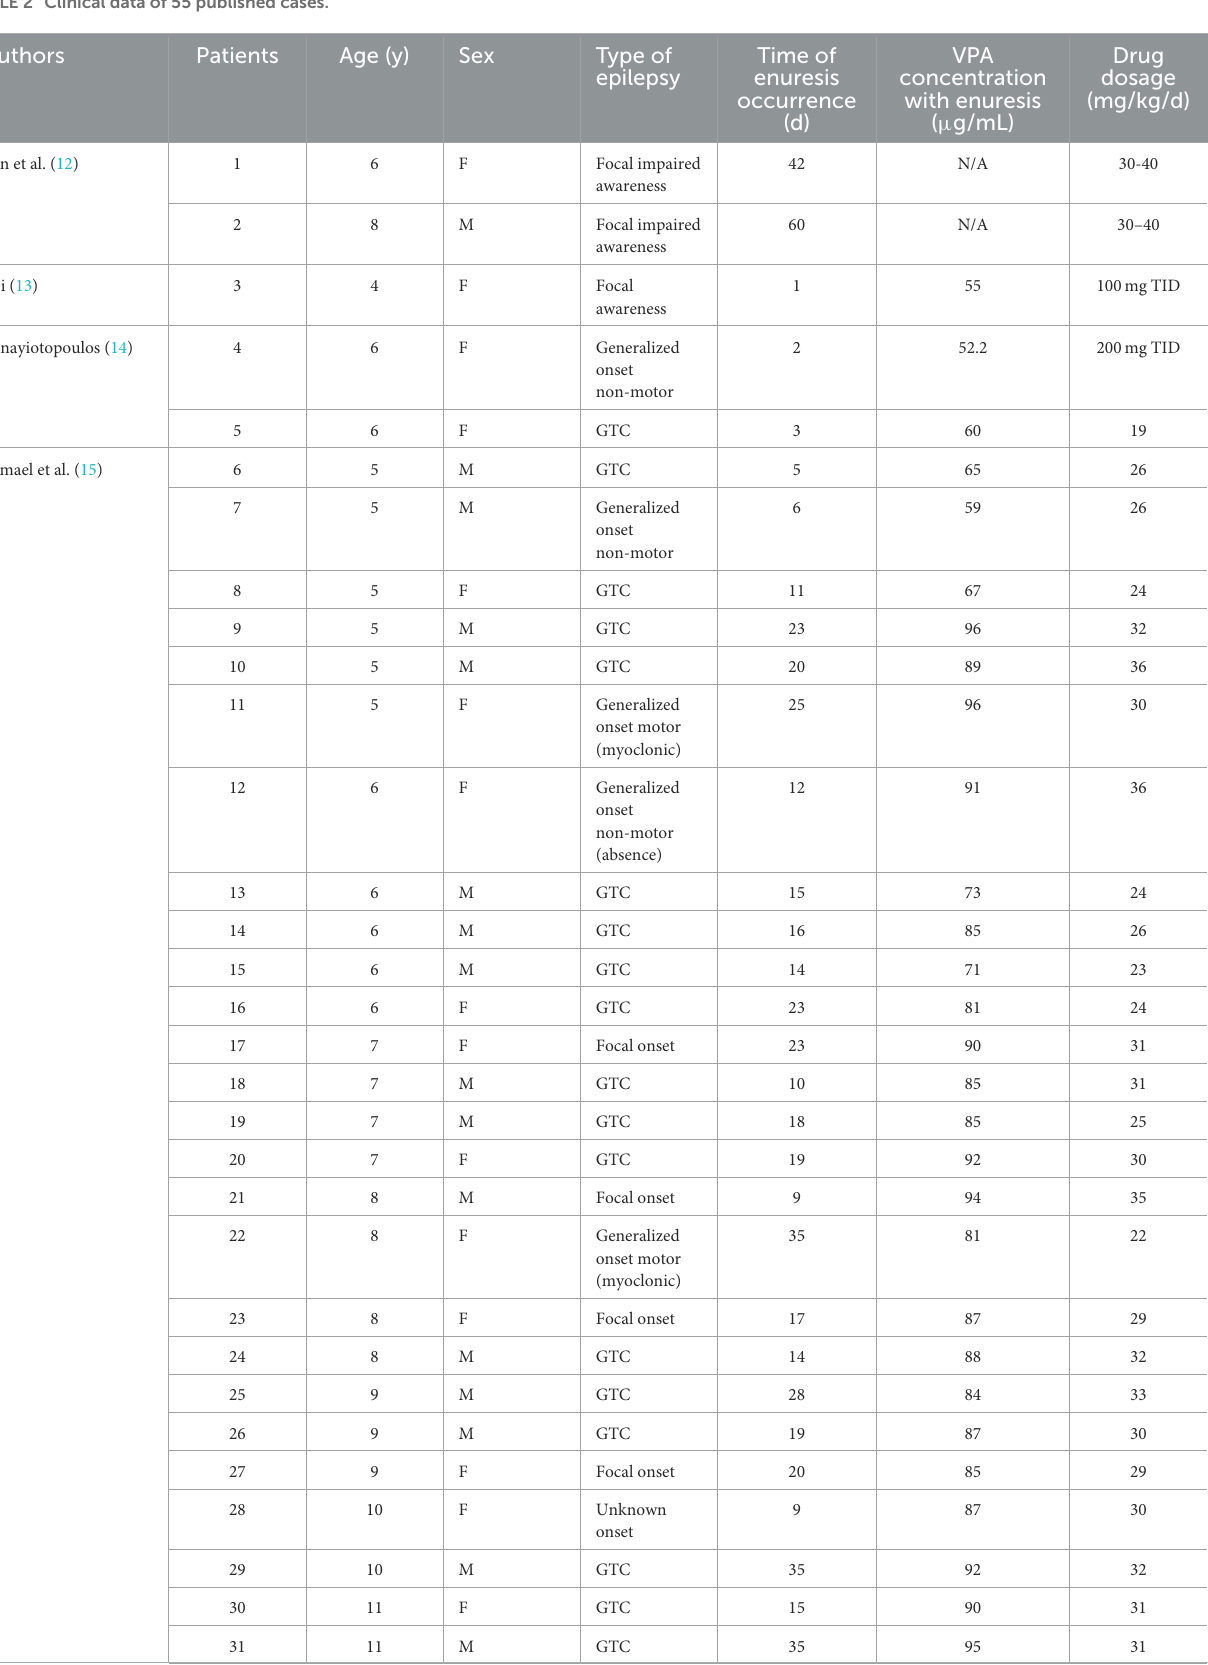
TABLE 2 Clinical data of 55 published